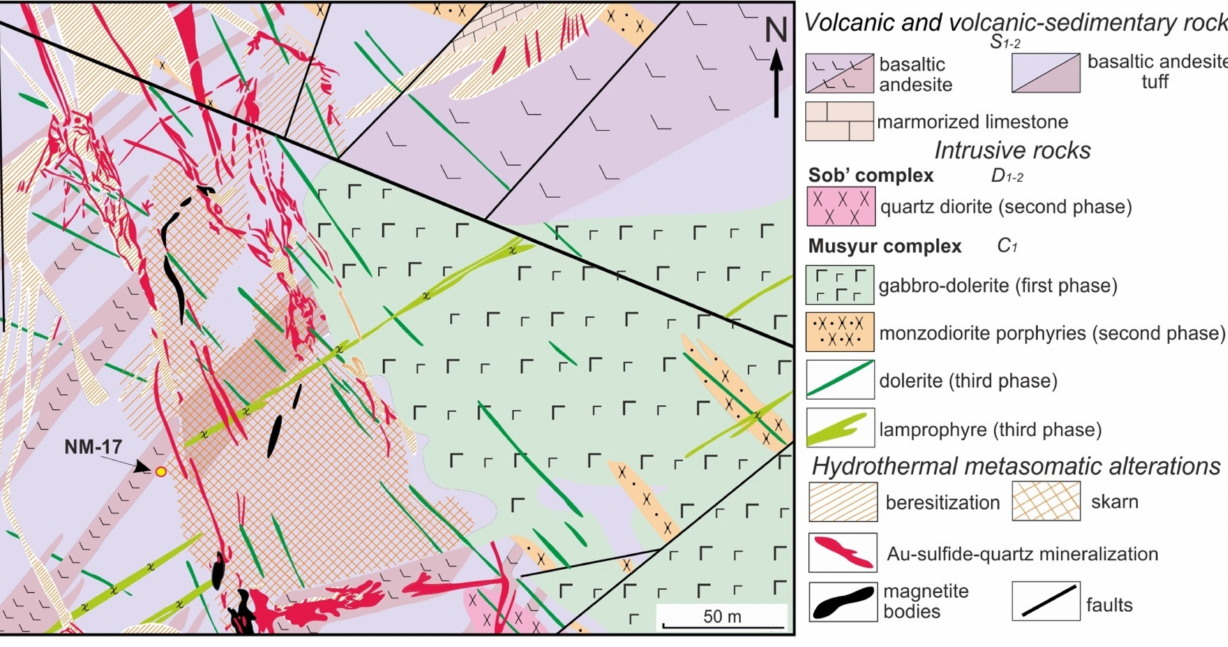
Figure 4. Geological scheme of the Novogodnee-Monto deposit. The labelled yellow dot indicates the sampling location (NM-17), was compiled using data from